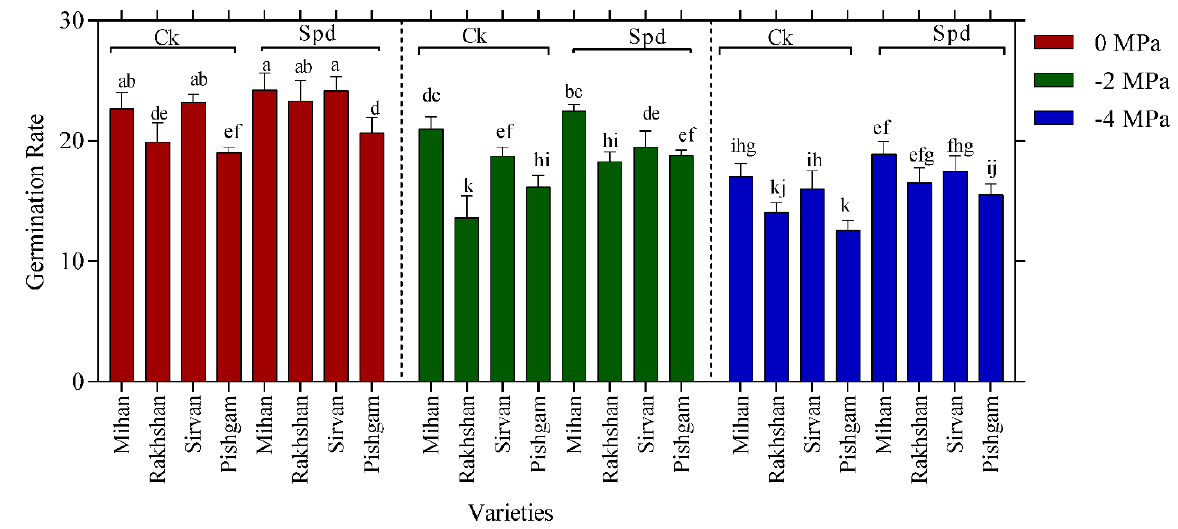
Figure 6. Effect of spermidine (Spd) on germination rate of four wheat varieties under drought stress with three levels of PEG 6000 osmotic potential ( − 2, − 4 MPa and 0 using distilled water as control). Ck = distilled water. Different letters indicate statistically significant differences across all three levels of PEG 6000 at p < 0.05 level using LSD’s test.